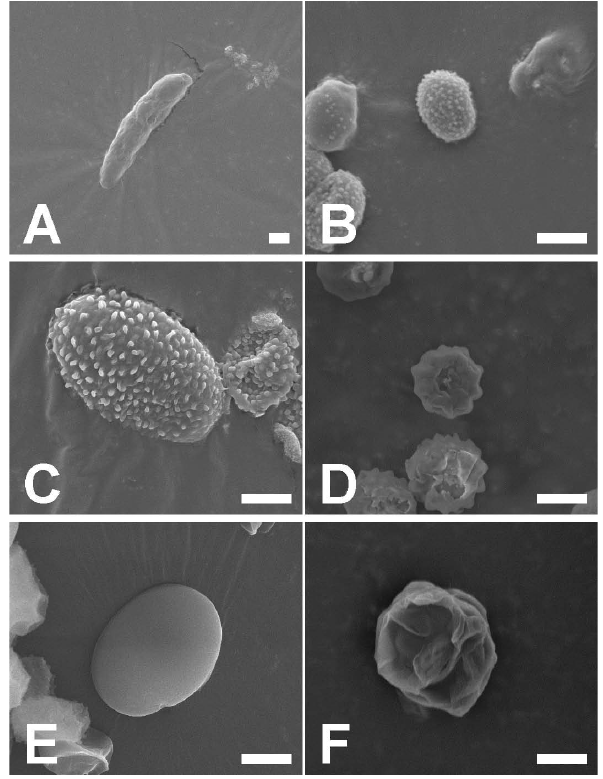
Fig. 1. Scanning electron microscopy images of some fungal spores: Fusarium avenaceum (A) , Trichoderma atroviride (B) , Cladospo- rium herbarum (C) , Aspergillus niger (D) , Agaricus bisporus (E) and Lentinula edodes (F) . The white bar represents a length of 2µm and is valid for all pictures.